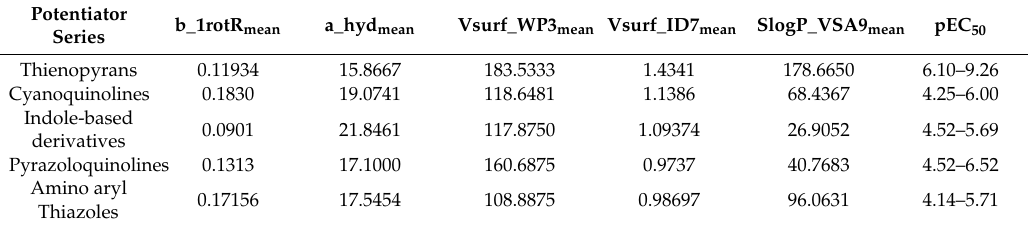
Table 4. List of the mean values of the most relevant 3D descriptors (RI > 0.5) and of 2D descriptors chosen as reference parameters within the di ff erent 2D subtypes. All of them have been calculated based on the several chemotypes explored